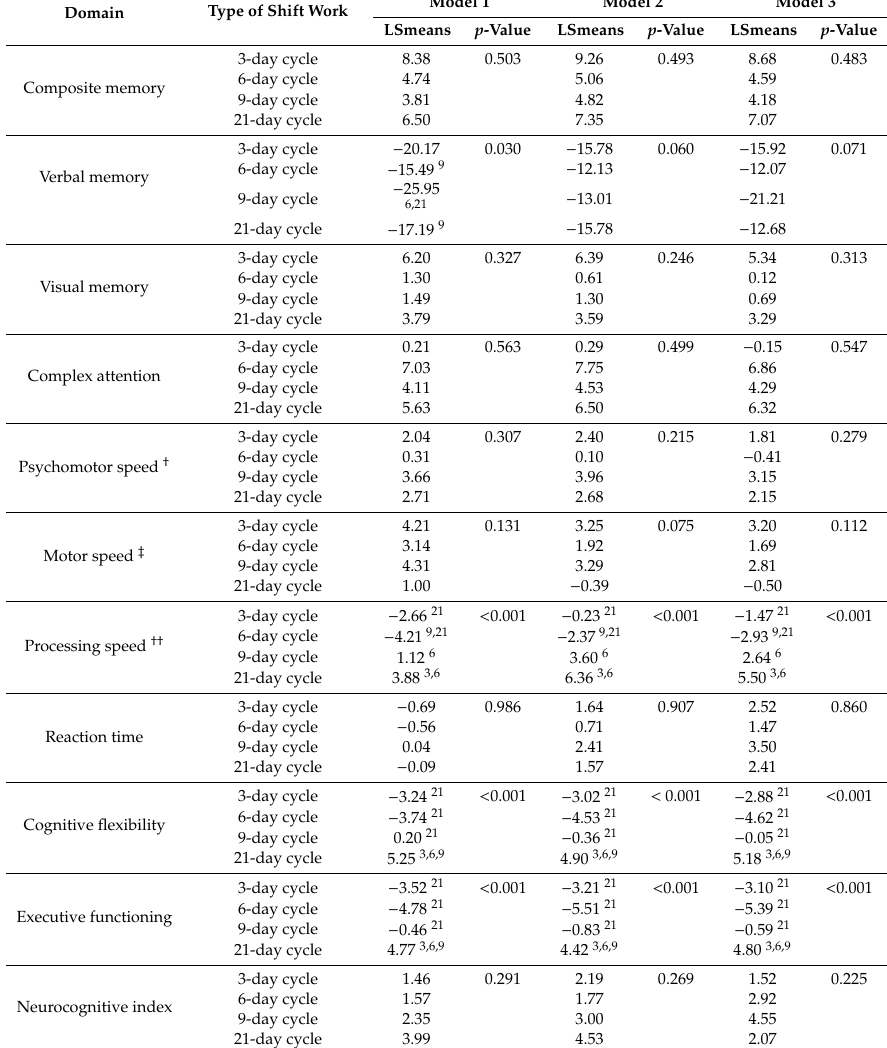
Table 5. Comparison of the changes of neurocognitive function according to the type of shift